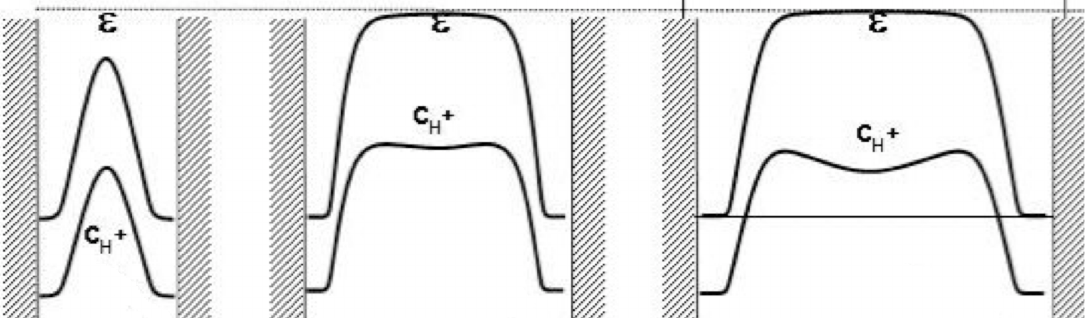
Figure 7. Statistical mechanical models of the dielectric ε and hydronium concentration, c in a pore at three water contents [36,37]. The dielectric ranges from 2 to 80 while the H + proton density decays to zero at pore walls. Reprinted (adapted) with permission from